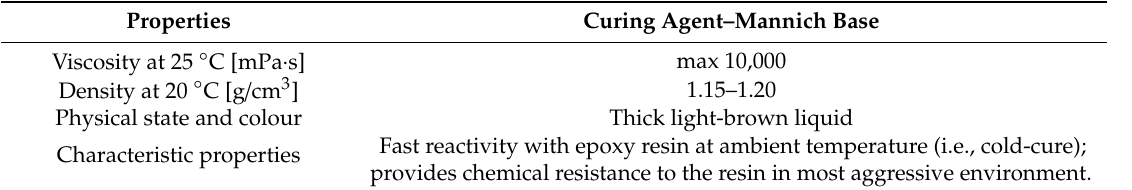
Table 2. Properties of the Mannich base (TFF) curing agent.